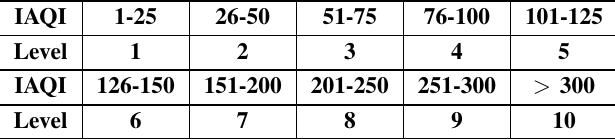
TABLE III P OLLUTION S PLITTING L EVELS FOR G ROUP O